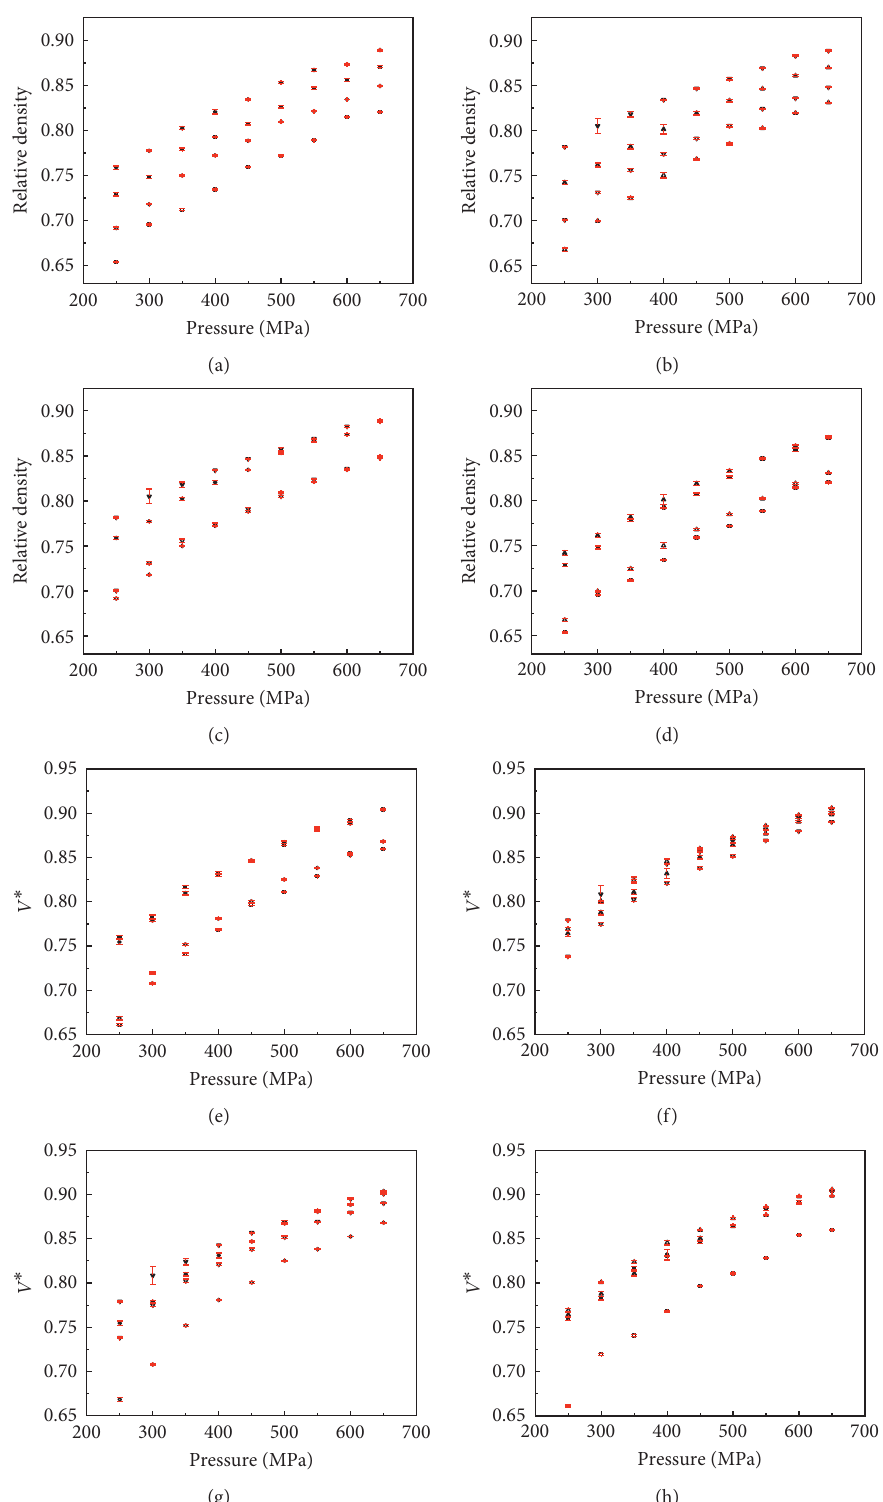
Figure 9: Relative densities (a–d) and V ∗ parameters (e–h) versus compaction pressure for TiH